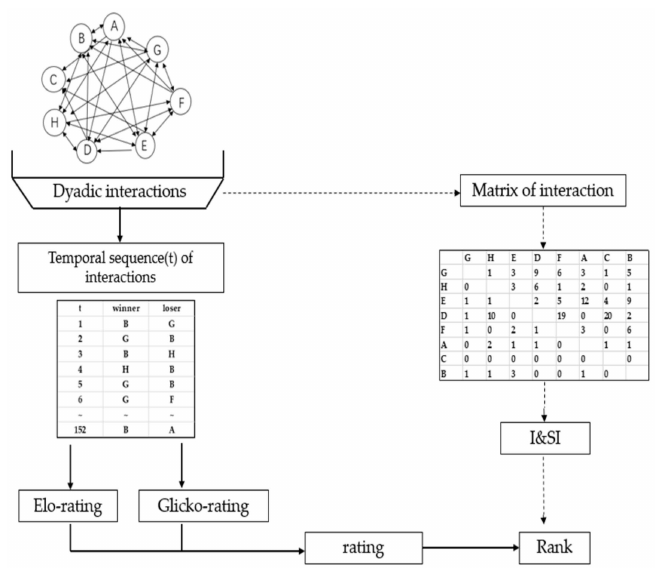
Figure 1. Diagram highlighting the di ff erent steps required to infer dominance hierarchies. Data shown are based on 152 interactions simulated among eight individuals from pen A. The direction of the arrows indicated the direction of the attack. The outcome of dyadic agonistic interactions between individuals was recorded either in the form of a matrix or as a temporal sequence of winners and